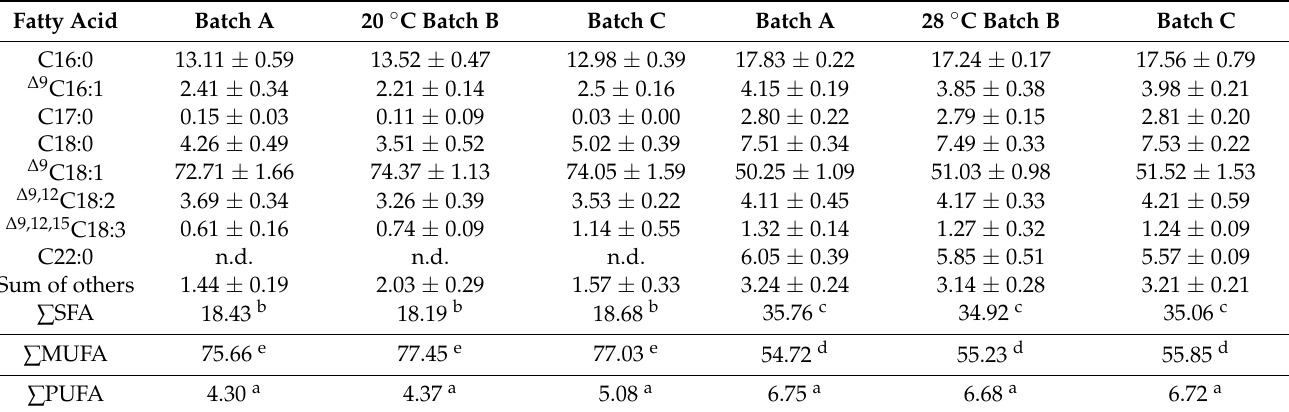
Table 2. The fatty acids range composition of extracted lipids from yeast biomass after 144 h of